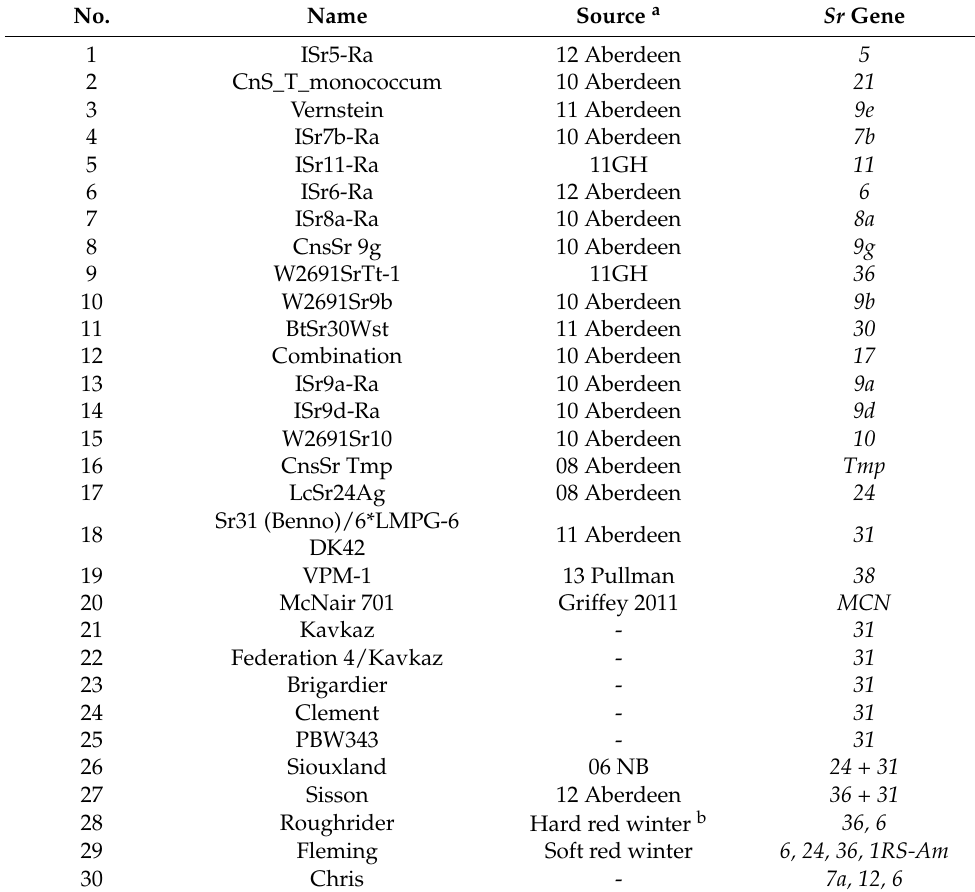
Table 1. The list of wheat monogenic lines and varieties with Sr genes ( Sr’ s) used in this study. No. Name Source a Sr Gene 1 ISr5-Ra 12 Aberdeen